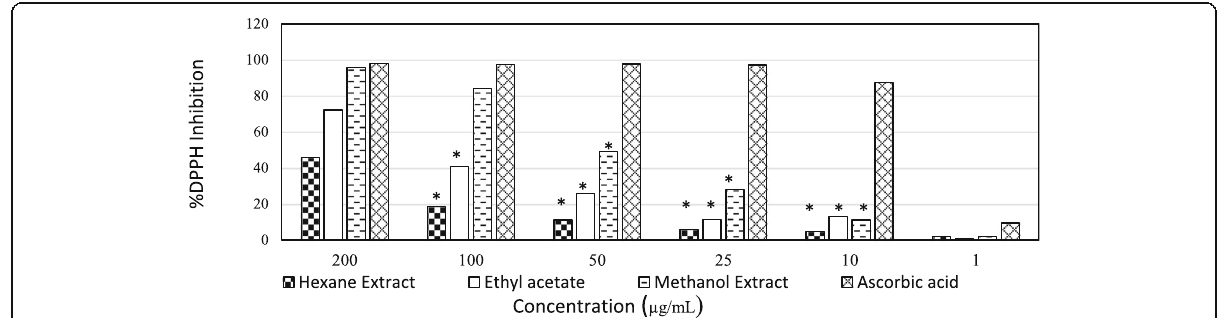
Fig. 1 The antioxidant capabilities of crude extracts from Desmodium canum (Strong Back)